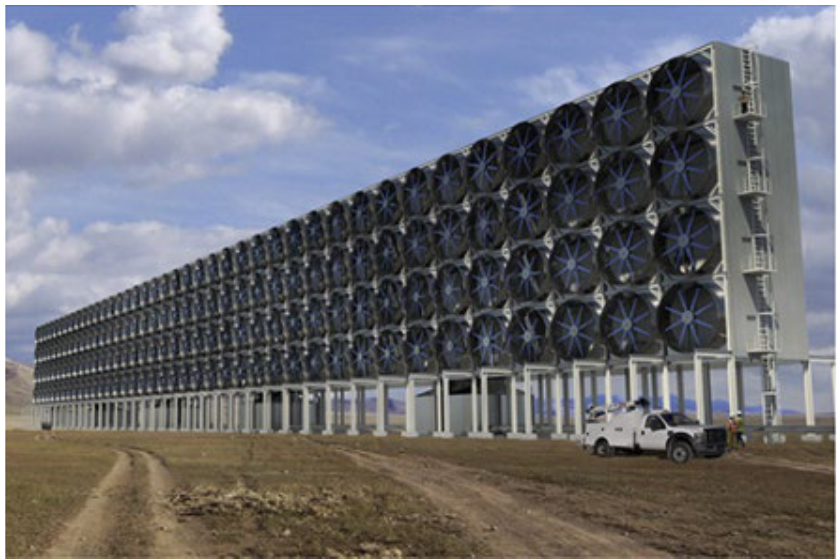
Figure 14. Carbon Engineering plant in Texas . Reproduced under a Creative Commons license